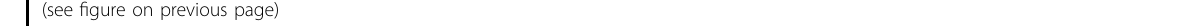
Fig. 1 Description and characterization of sensor device. a Schematic illustration of a micro-LED ( μ LED)-embedded photoactivated ( μ LP) gas sensor device. The inset illustrates a cross-sectional structure of the sensor device. b , c Optical microscopic images of the fabricated sensor and near ultraviolet light-emitting μ LED ( λ peak = 395 nm) with forward bias = 2.9 V. d , e Transmission electron microscopy and scanning electron microscopy images of cross-sectional and top views of gold NPs coated porous, columnar indium oxide (In 2 O 3 ) sensing fi lm deposited by a glancing angle deposition (GLAD) method. f Schematic illustration explaining the mechanism and advantages of pulsed illumination operation. L2 has a stronger light intensity than L1. By using random pulsed illumination instead of the steady illumination of μ LEDs, more unique response data can be generated from each target gas within the same amount of time, enabling selective gas discrimination with a single sensor. g Calibration curves of the μ LP gas sensor with representative reducing gases such as methanol (CH 3 OH), ethanol (C 2 H 5 OH), acetone (CH 3 COCH 3 ), and nitrogen dioxide (NO 2 ) under continuous illumination of μ LED (forward bias = 3 V). h Dynamic sensor responses ( R and Δ R/R 0 ) to 10-ppm methanol, 10-ppm ethanol, 200-ppm acetone, and 0.5-ppm